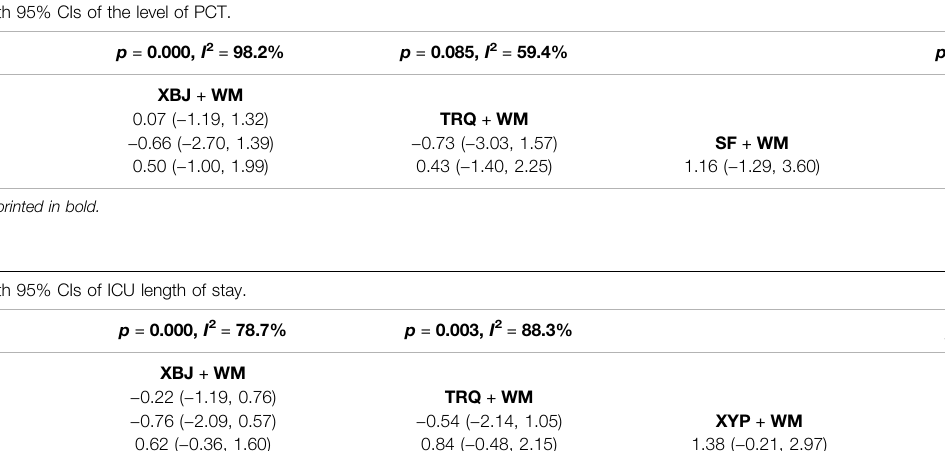
Signi fi cant effects are printed in bold.